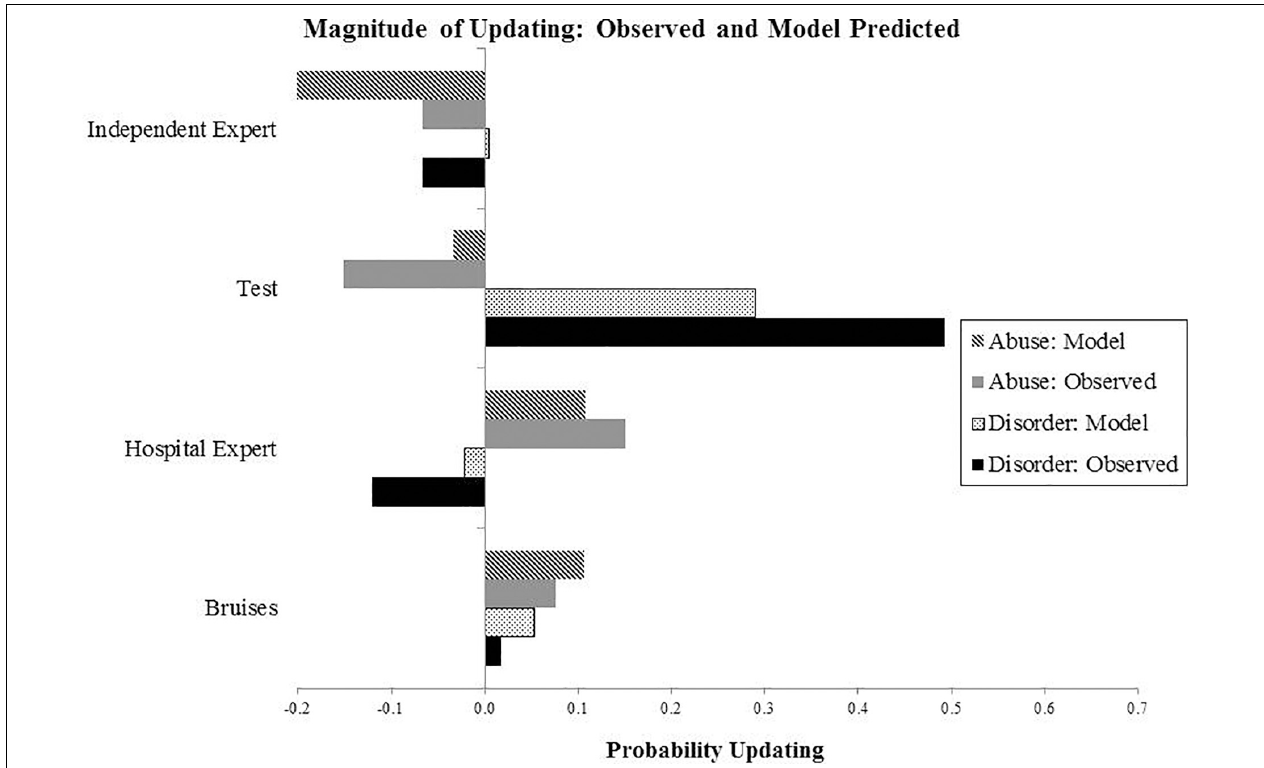
FIGURE 6 | Results from Experiment 2: The graph shows extent of updating at four stages of evidence presentation, calculated as a difference between the probability estimates at the present and previous evidence stage. For example, for the Hospital Expert evidence stage, this is calculated by subtracting the probability value at the previous stage (evidence of bruises) from the present stage (evidence of the hospital expert